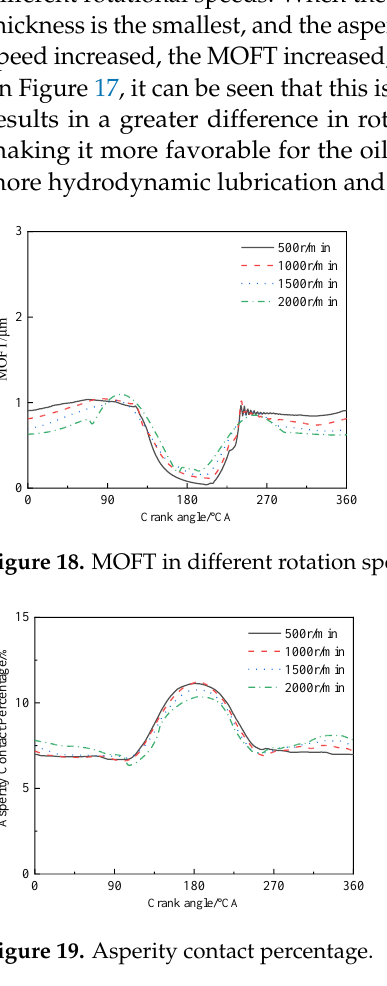
( b ) Figure 20. ( a ) Hydrodynamic lubrication friction power under different engine speeds. ( b ) Asperity contact friction power under different engine speeds. The oil film thickness increased at a higher rotation speed, which enhanced lubrication conditions. Additionally, the relative rotational speed of the piston pin and bushing increased, resulting in a significant increase in friction power. As a result, the